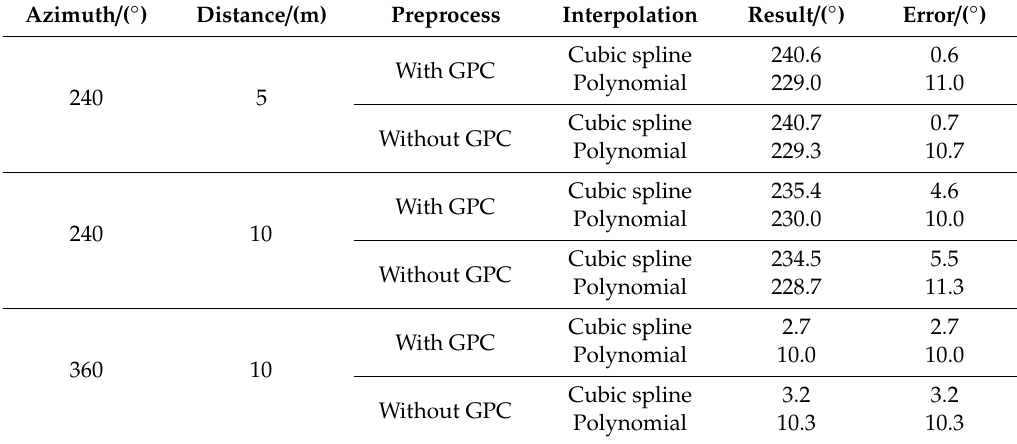
Table 1. Results of direction of arrival (DoA)